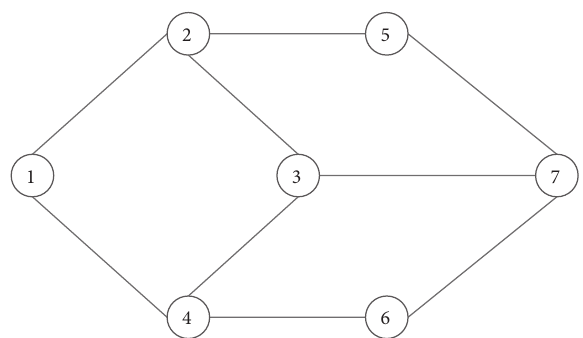
Figure 6: A simple network with 7 nodes.